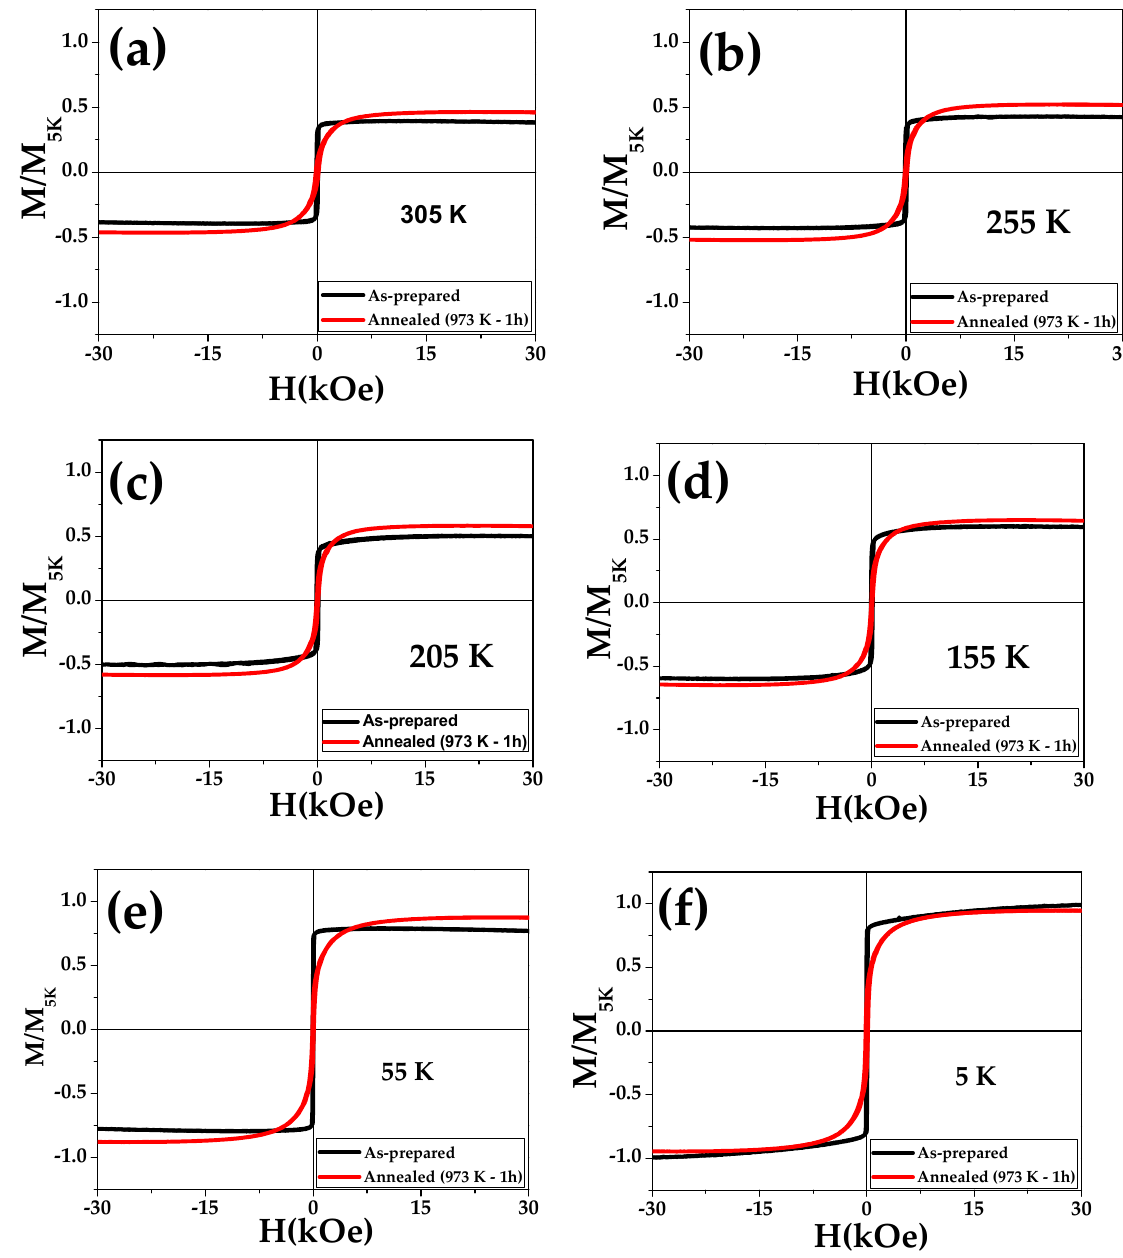
Figure 2. Magnetization curves M/M 5K (H) of as-prepared and annealed Ni 2 FeSi glass-coated microwires measured at maximum field 30 kOe.